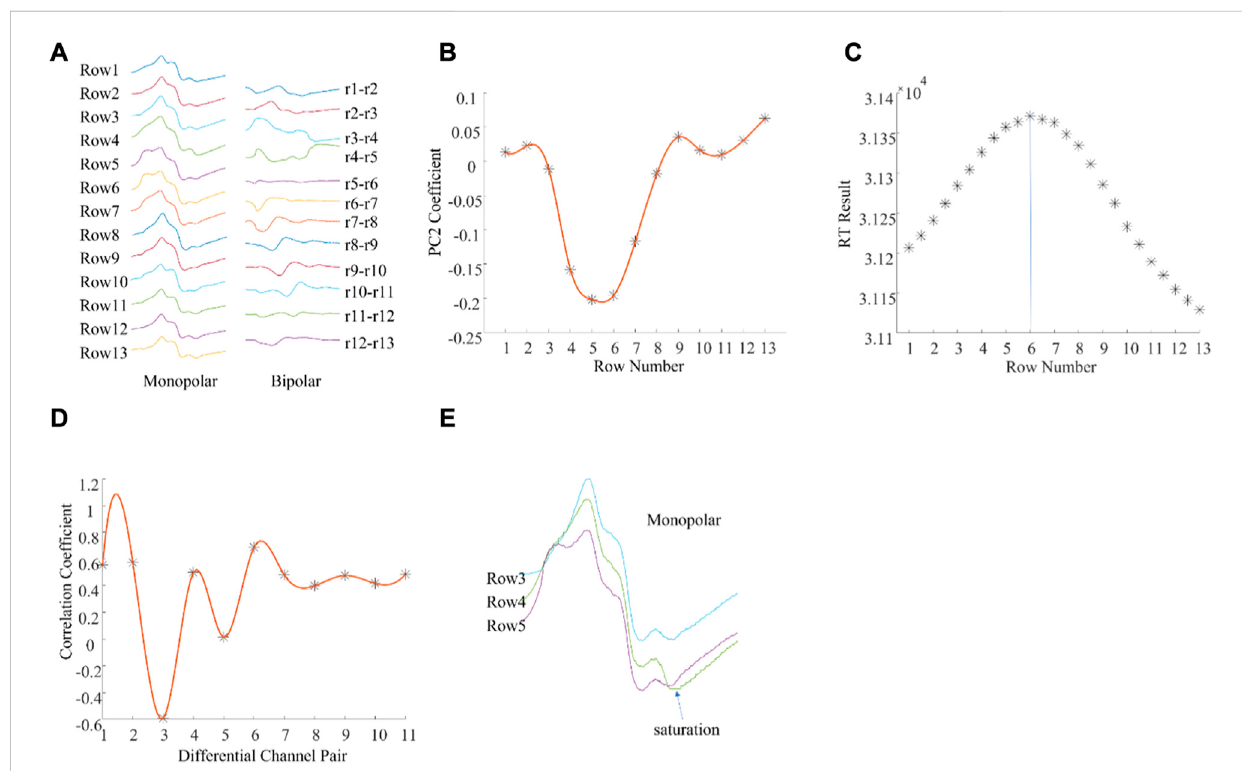
AnexampleofmuscleIZestimationfromexperimentalhighdensityMwaveswheredifferentmethodsproduceddifferentresults. (A) :AcolumnofM waves of a single subject. (B) : PCA based IZ estimation; (C) : RT based IZ estimation; (D) : Cross correlation based IZ estimation; (E) : Enlarged view of the monopolar M waves from rows 3, 4, and 5. See text for